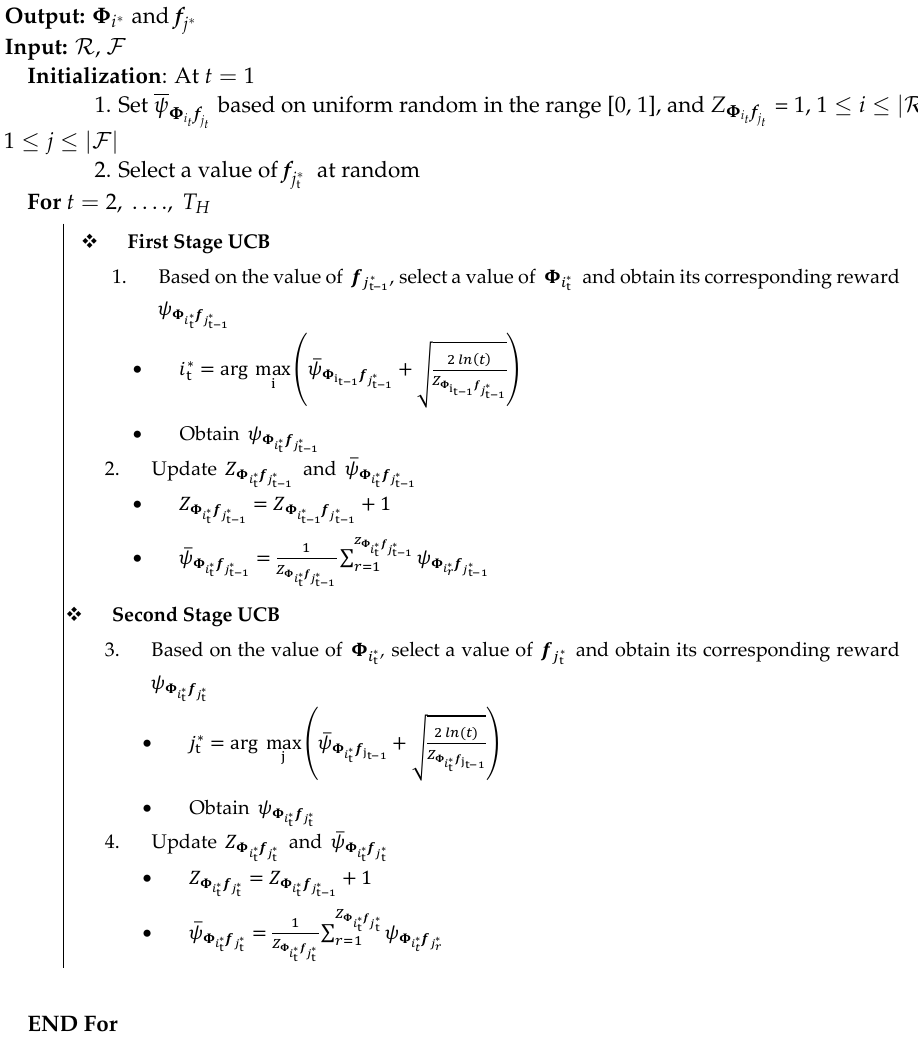
Algorithm 2. Nested Two-Stage UCB Algorithm